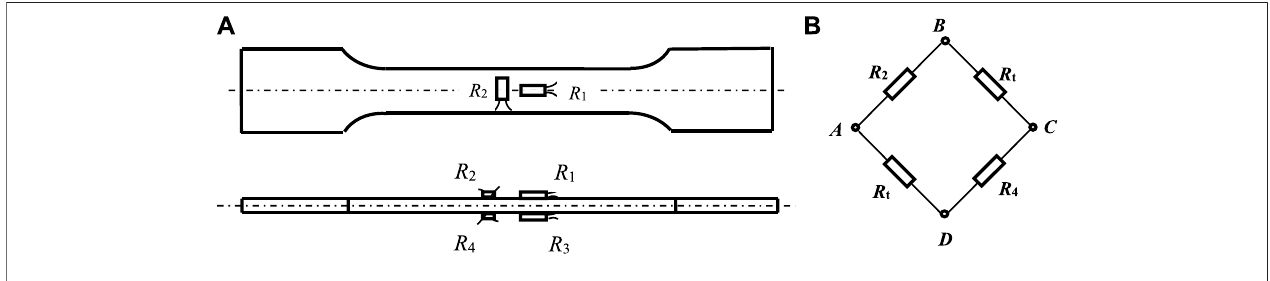
FIGURE 6 | Schematic diagram of (A) Strain gauge of double sides, and (B) Full-bridge